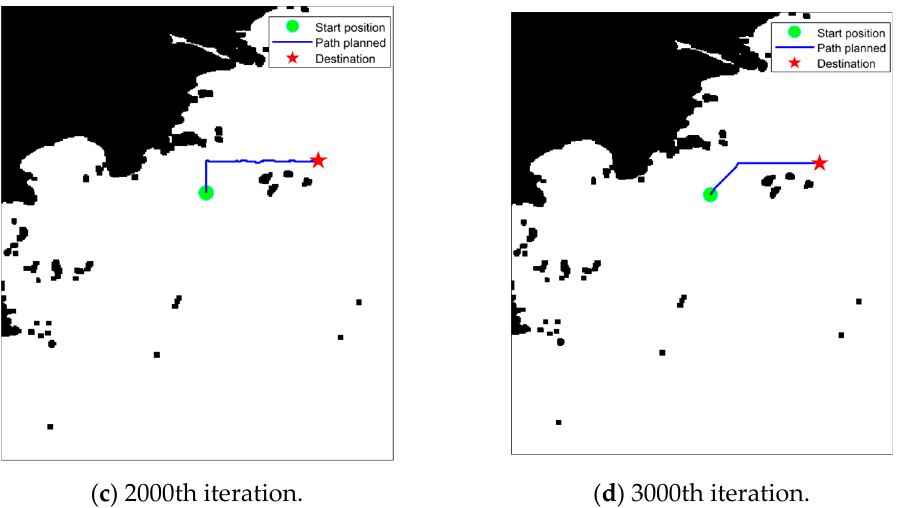
Figure 8. Path planning results under different iterations. ( a ) 500th iteration; ( b ) 1000th iteration; ( c ) 2000th iteration; ( d ) 3000th iteration.